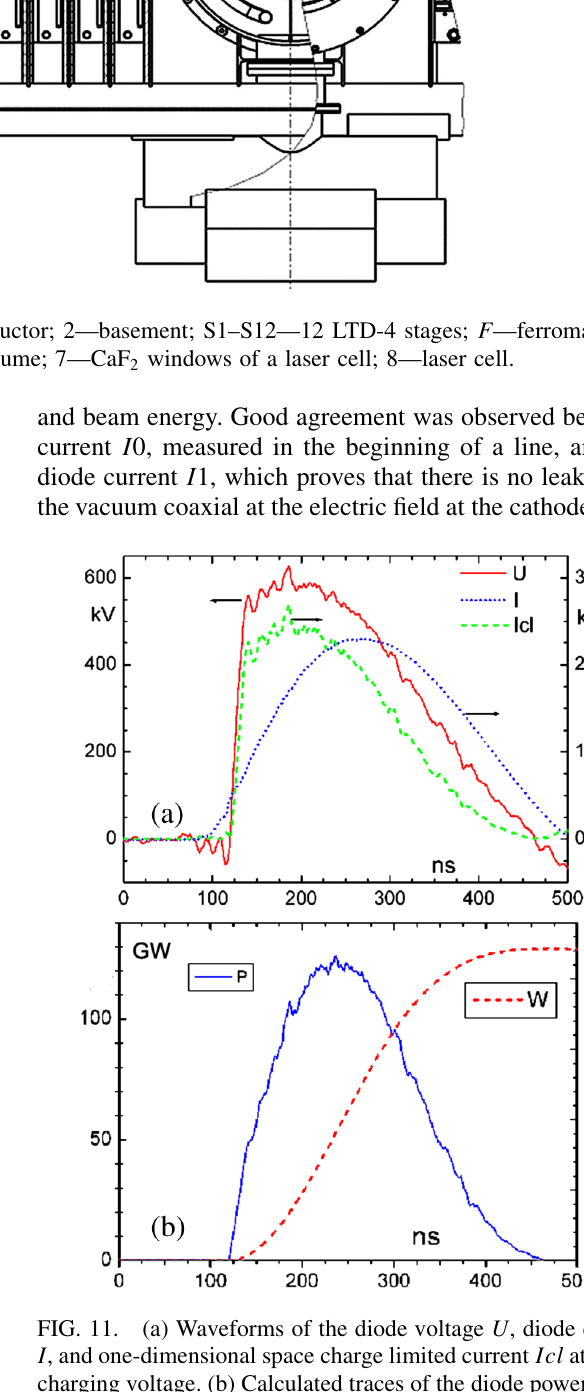
FIG. 10. Drawing of the acrylic insulator, installed between stages.